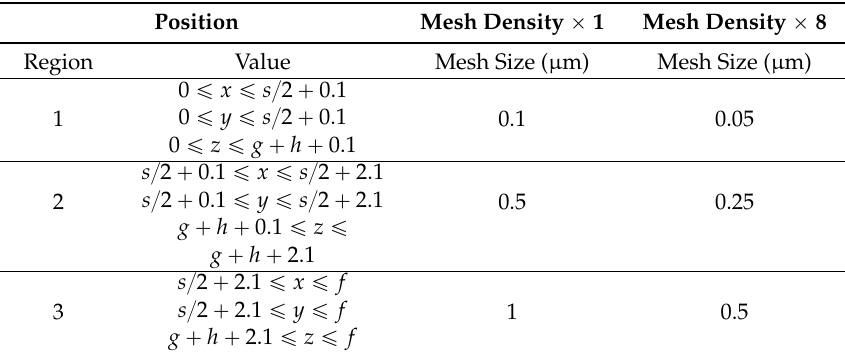
Table 2. Mesh sizes and densities.